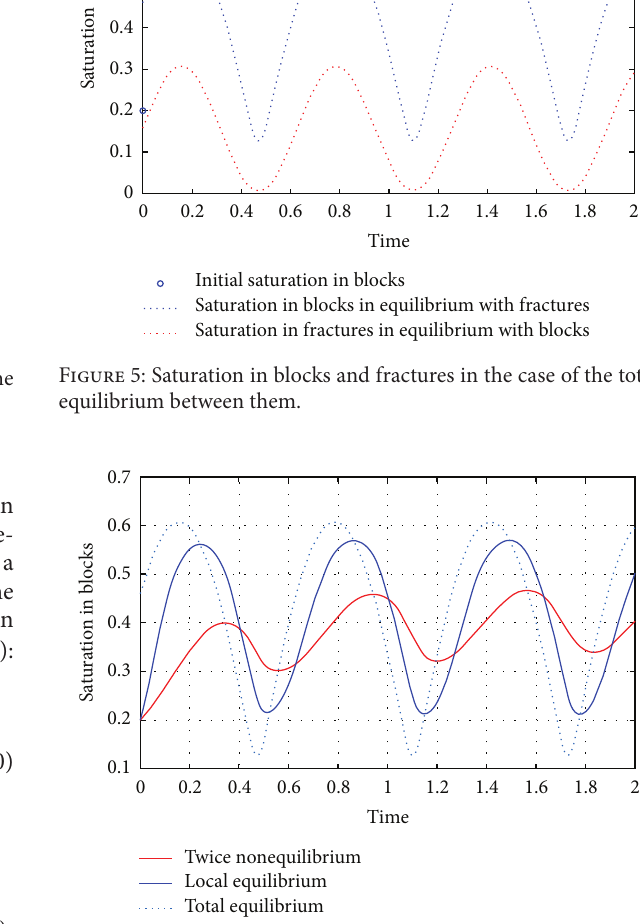
Figure 6: Evolution in time of the saturation in blocks from the initial nonequilibrium state; at periodically oscillating saturation in